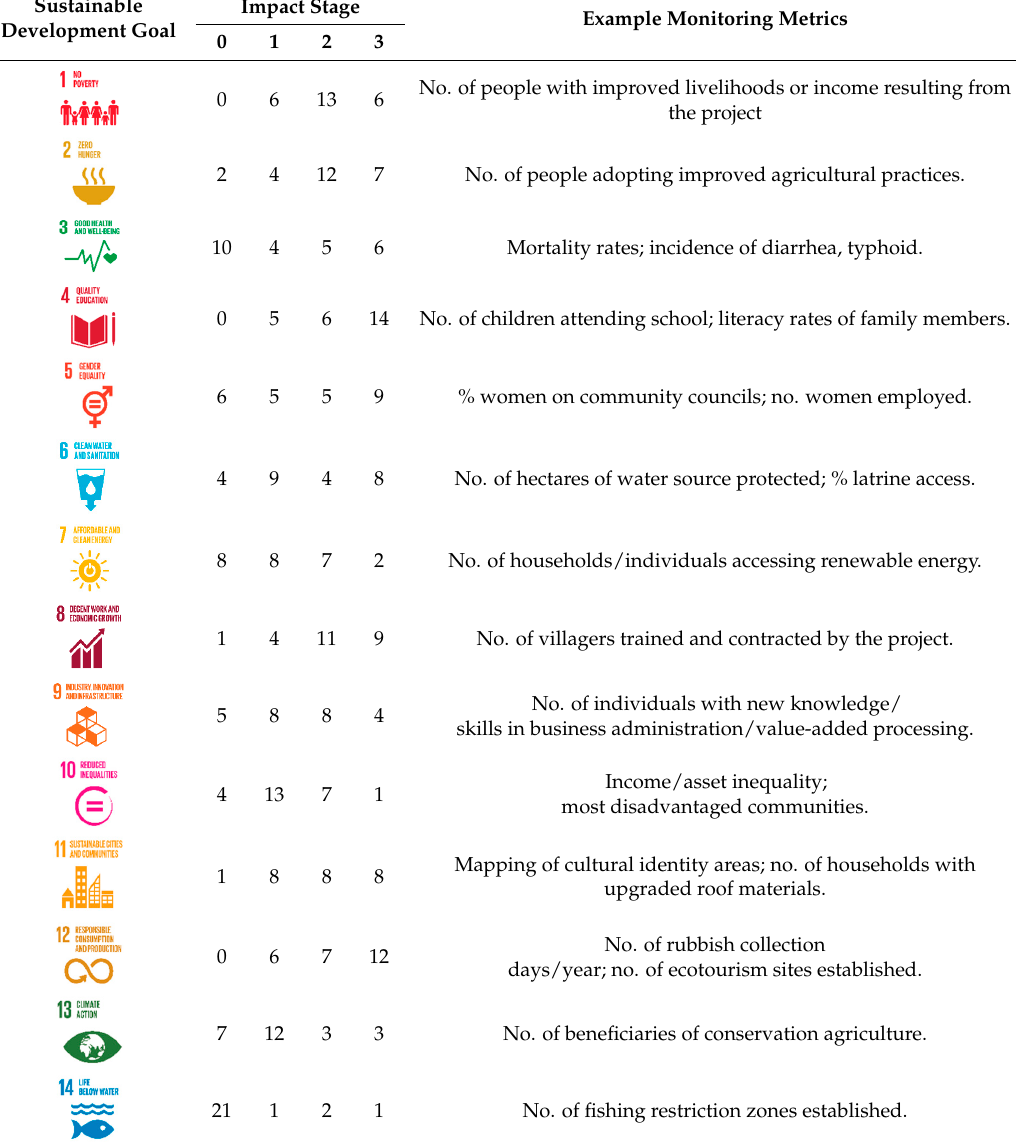
Table 2. The number of projects (out of 25) that have reached the impact stages (0–3) recorded by SDG. 0 = not targeted; 1 = insufficient info; 2 = monitoring variable identified/variables are being monitored; 3 = evidence of monitoring and improvement.